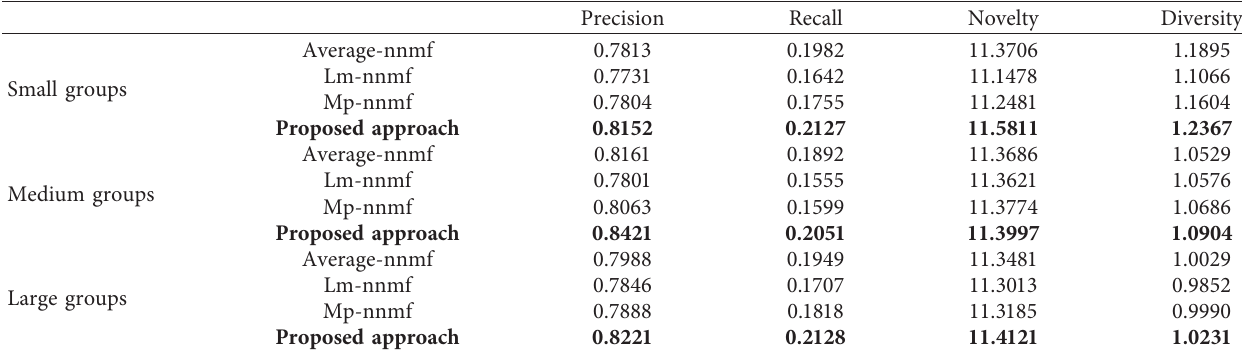
Figure 11: Diversity of the three types of group recommendations’ evaluation. Table 6: Average precision, recall, novelty, and